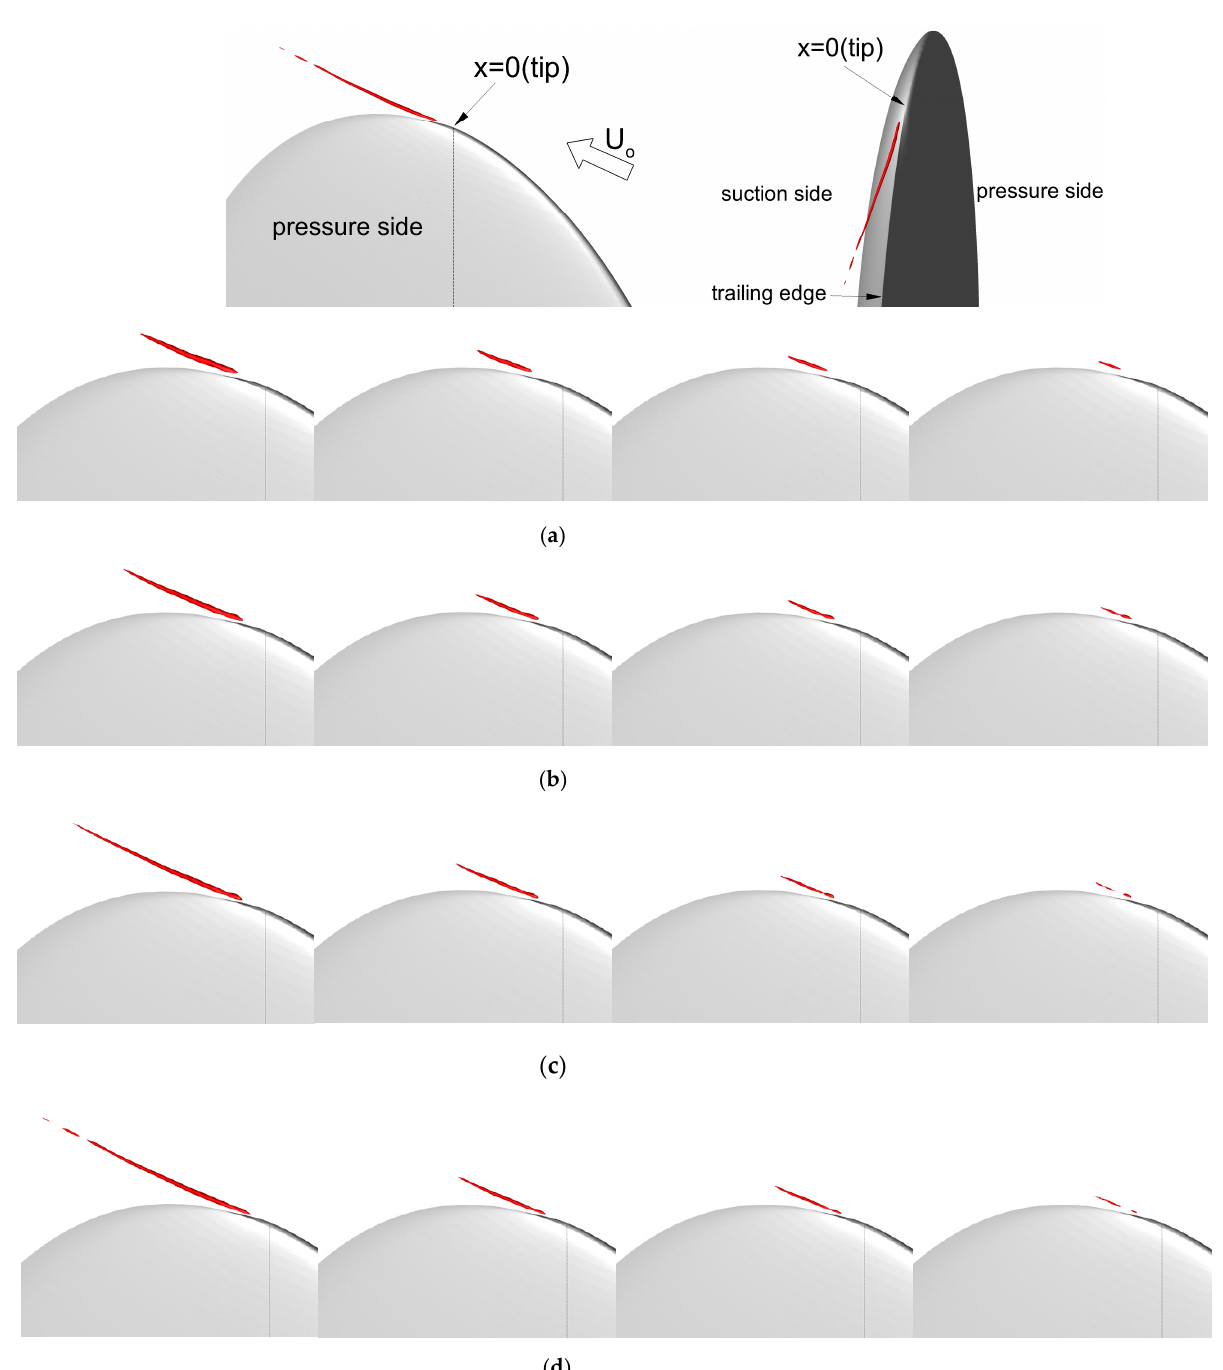
Figure 18. Tip vortex cavitations predicted at different Reynolds numbers and cavitation numbers: ( a ) R e = 5.0 × 10 4 , σ = 1.0, 1.1, 1.15 and 1.20; ( b ) R e = 1.0 × 10 5 , σ = 1.68, 1.90, 2.0 and 2.1; ( c ) R e = 3.0 × 10 5 , σ = 2.5, 2.8, 3.0 and 3.15; ( d ) R e = 1.0 × 10 6 , 𝜎 = 3.0, 3.4, 3.6 and 3.8.